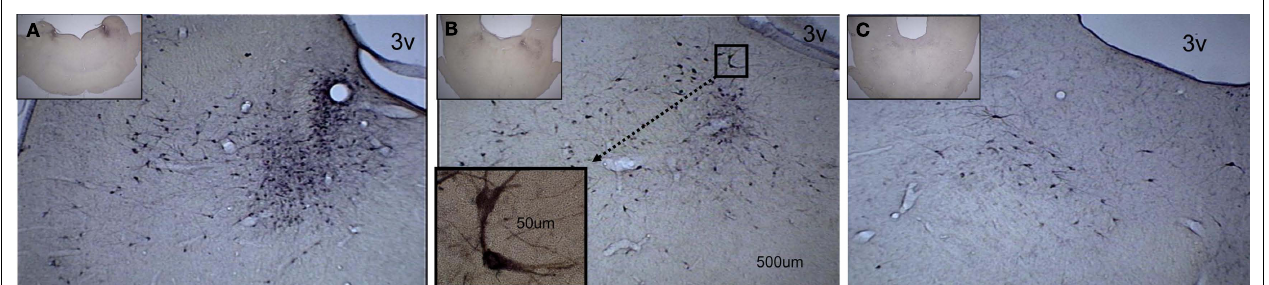
caudal sites.The scale bar is the same on three of the photomicrographs and applies to the high-power (10 × ) picture. (B) At this level, fewerTH-ir cells are seen.The insert shows a higher-power (63 × ) view of a pair ofTH-ir cells.Their location in the 10 × section is indicated by the dotted line connecting the two boxes. (C) The most rostral section has the fewestTH-ir cells. 3v designates the third